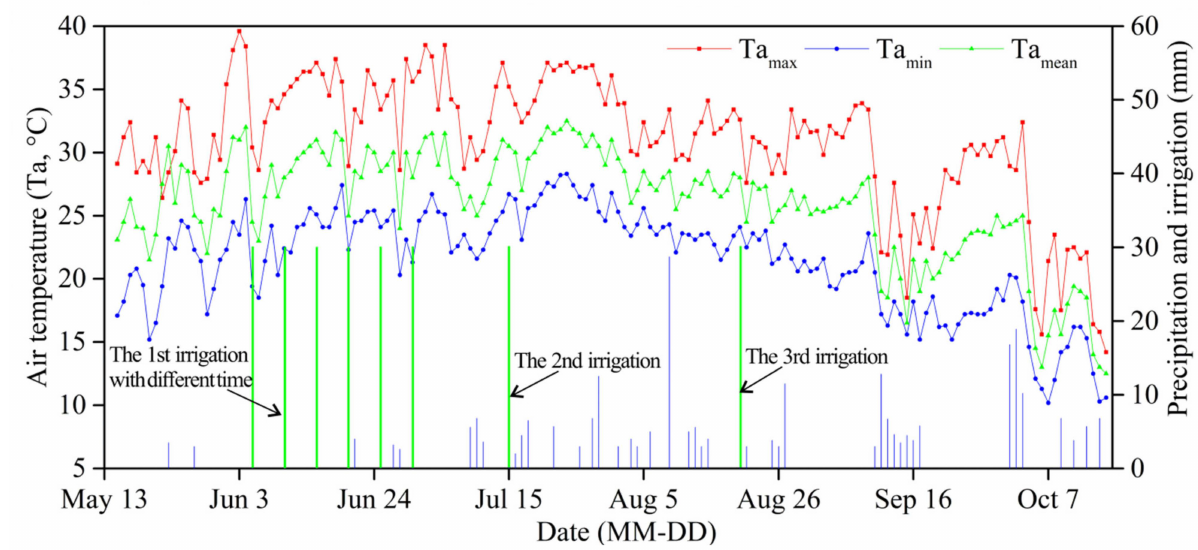
Figure 2. Maximum, mean, and minimum air temperature, irrigation time and amount, and precipi- tation at the experimental site in 2019 growing season of